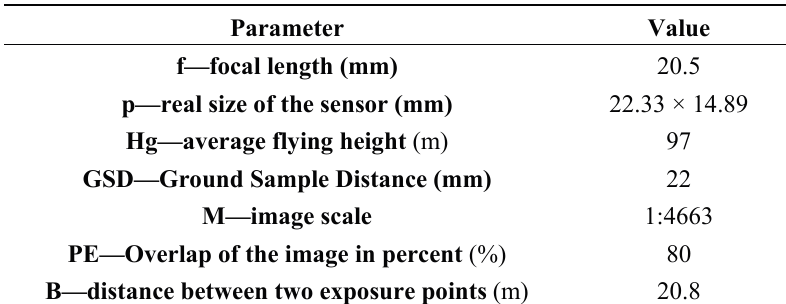
Table 2. Calculated parameters of imaging.